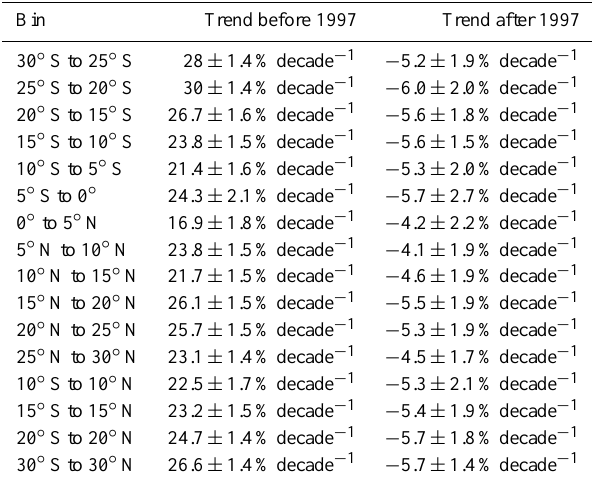
Table 1. HALOE trend and uncertainty (2 σ ) estimates before and after